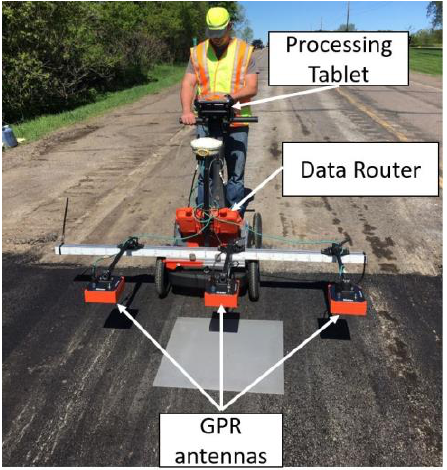
Figure 1. Density profiling system (DPS) equipment during data collection.